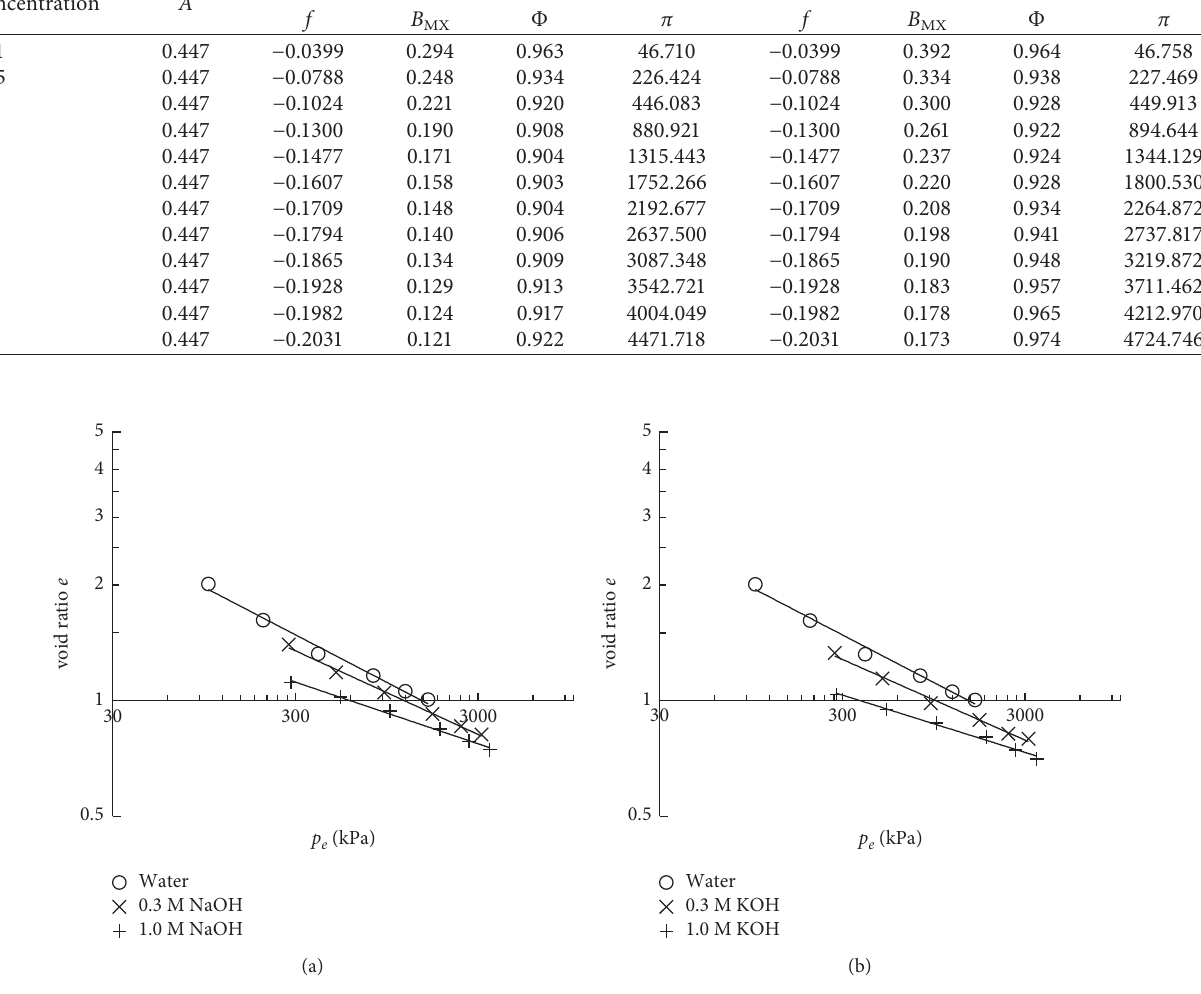
Figure 6: The e - p e relationship curve of bentonite in NaOH and KOH